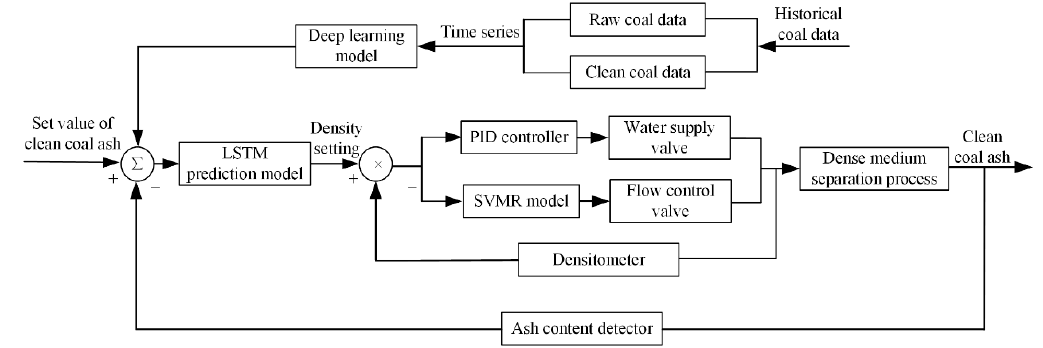
Figure 1. Dense medium separation control system.